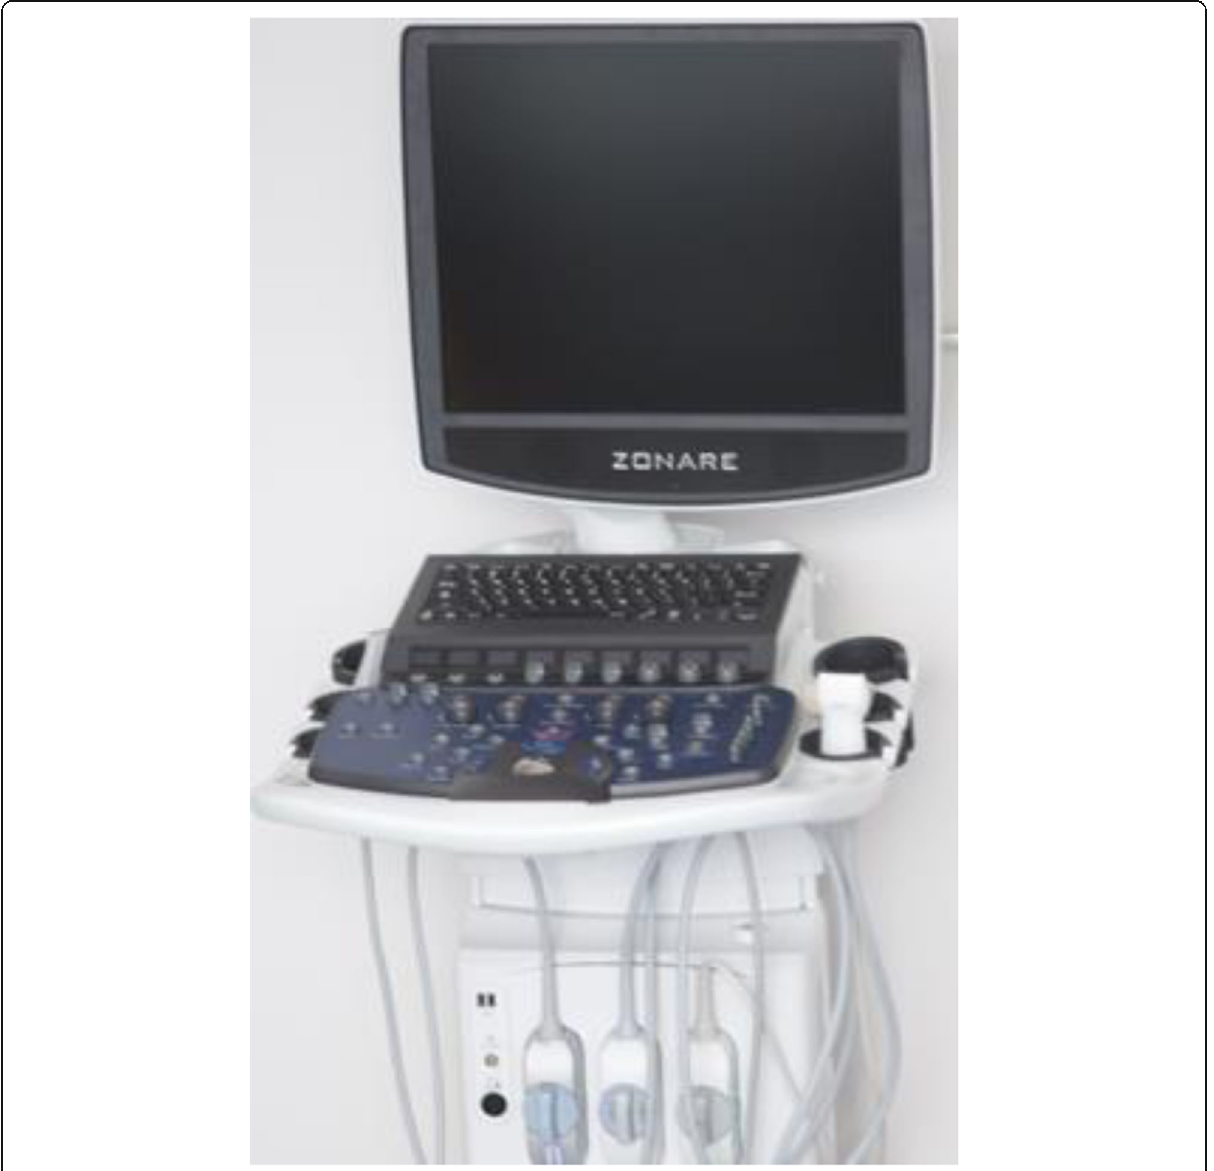
Fig. 1 Ultrasound device, model ZS 3 (Mindray Innovation Center, Mindray North America, San Jose, CA,